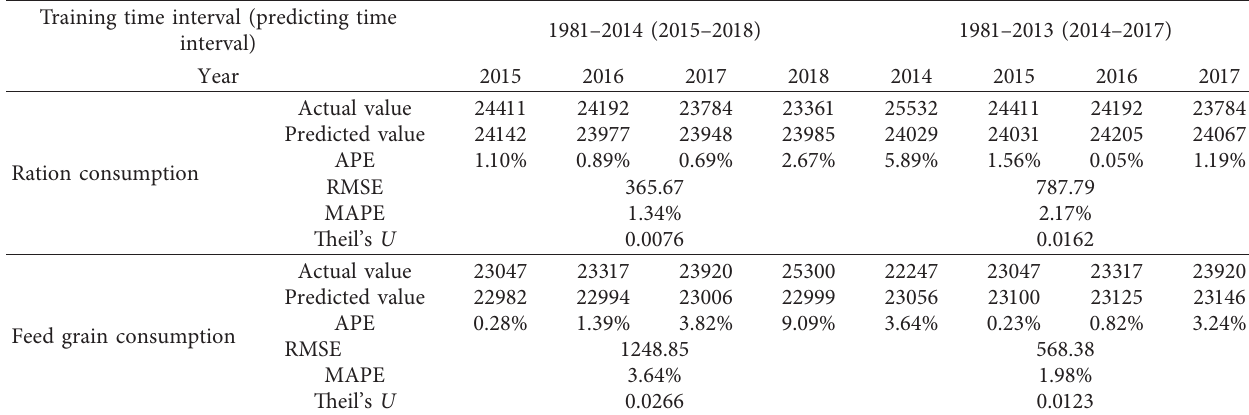
Table 5: Comparison of feed grain consumption prediction results in China (2014–2018) (unit: ten thousand tons). Training time interval (predicting